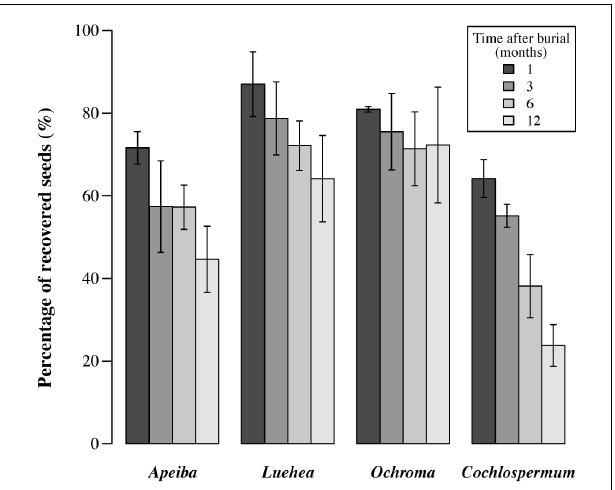
FIGURE 2 | Percentage of seeds retrieved at different time intervals. Seed decay is equivalent to the total number of seeds buried (i.e., 100%), minus the number of seeds recovered successfully at each time. Error bars correspond to